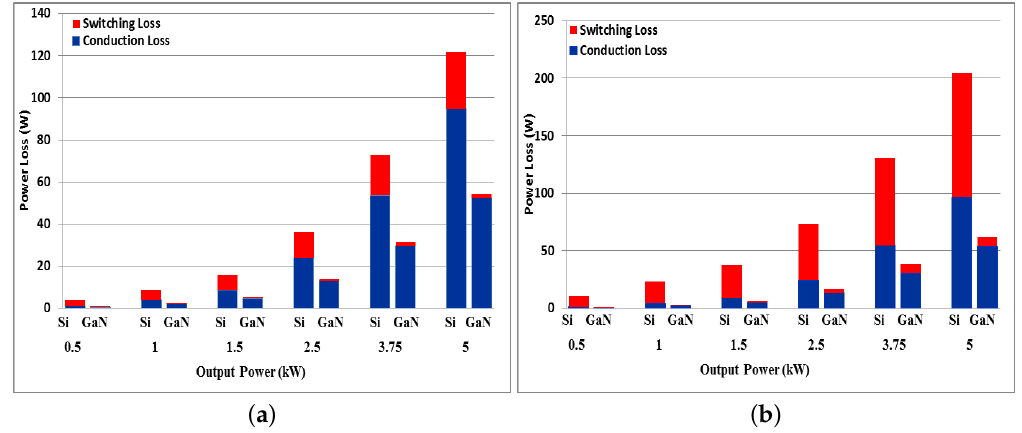
Figure 9. Power losses of Si MOSFET and GaN HEMT: ( a ) at 50 kHz; ( b ) at 200